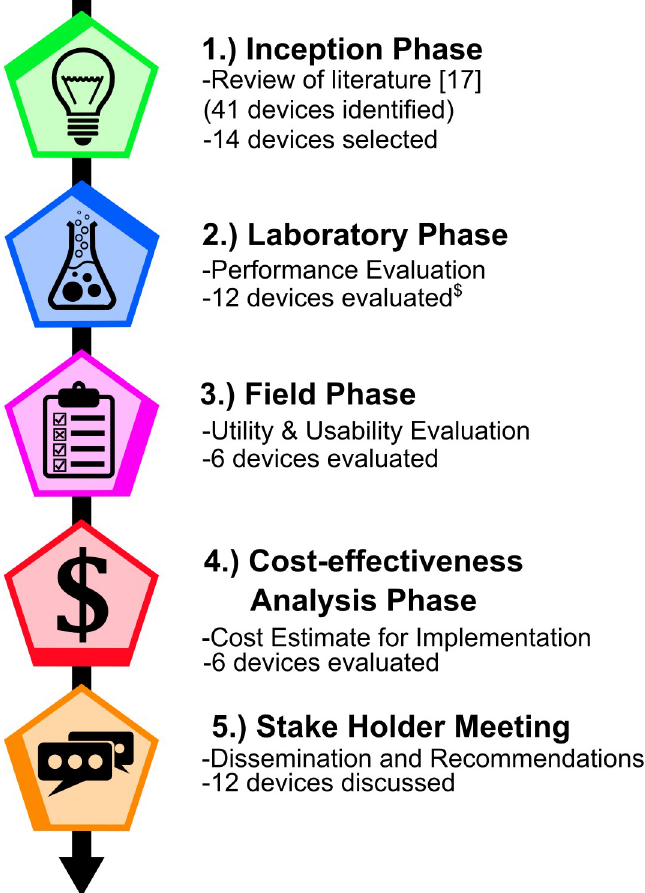
Fig 1. Diagram of the outline for the overall project. $ The CoDI (developed by the United States CDC)—a device that uses laser absorption and fluorescence—could not be assessed because of intellectual property issues. A misunderstanding of the operational procedures of the CD3+—a device using UV-Vis-IR light to reveal differences in the packaging as compared to its genuine counterpart (developed by the US FDA)—led to potential significant bias in the performance results of the device during its evaluation. Those are thus not presented in this article. CDC, Centers for Disease Control and Prevention; CoDI, Counterfeit Detection Indicator; FDA, Food and Drug